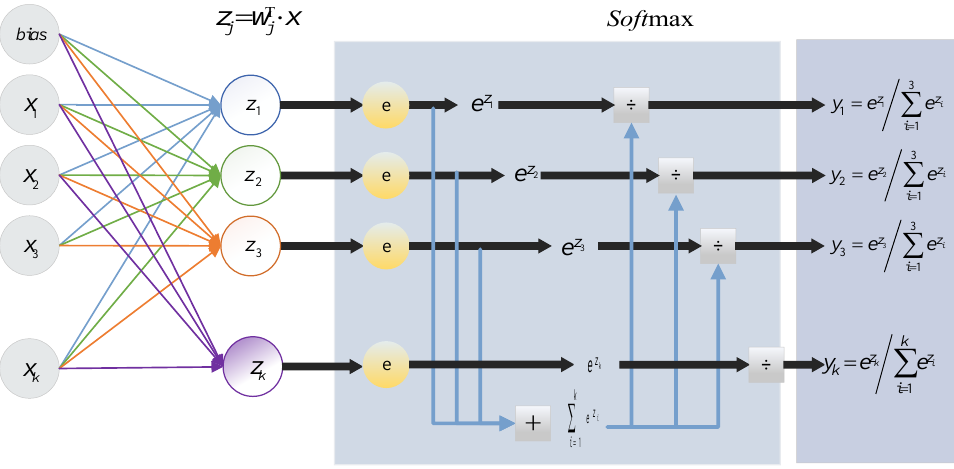
Figure 9. The classification output layer.